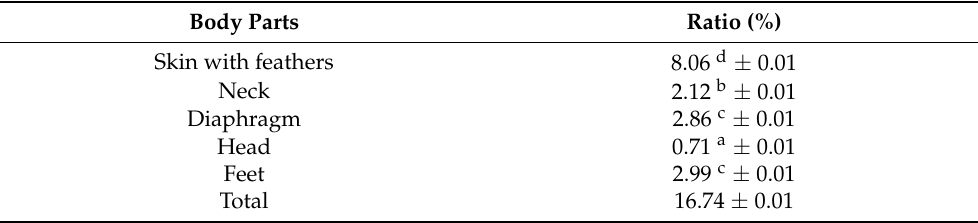
Table 1. The ratio of body parts expressed in the percentage of live weight ( n = 10).